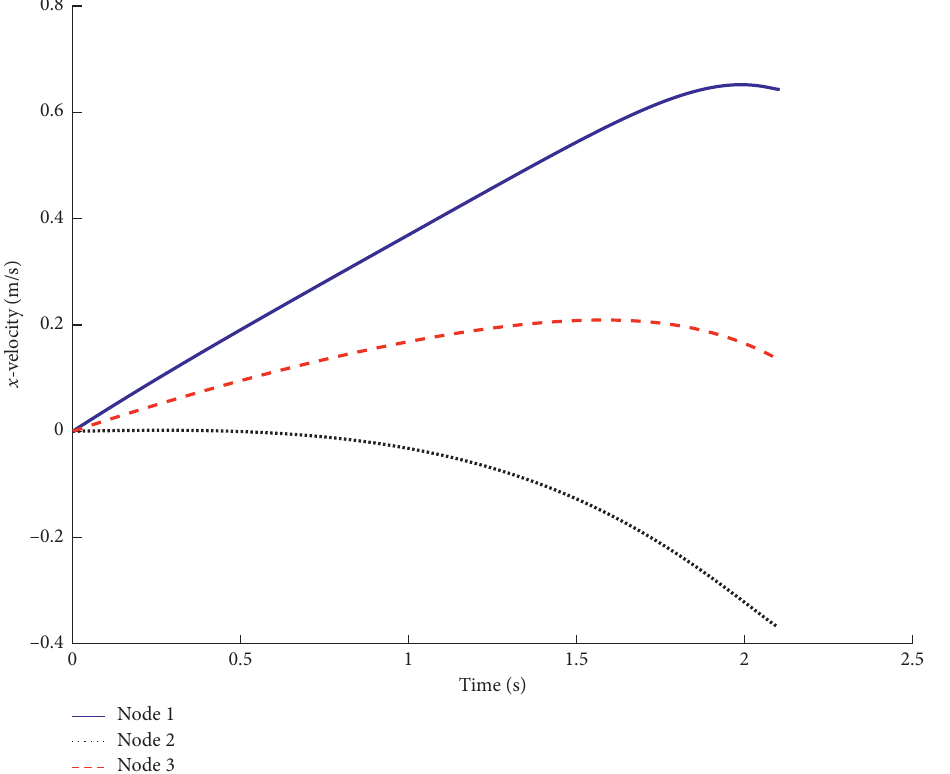
Figure 6: Curves of x -velocity over time for some nodes in the deployable structure.